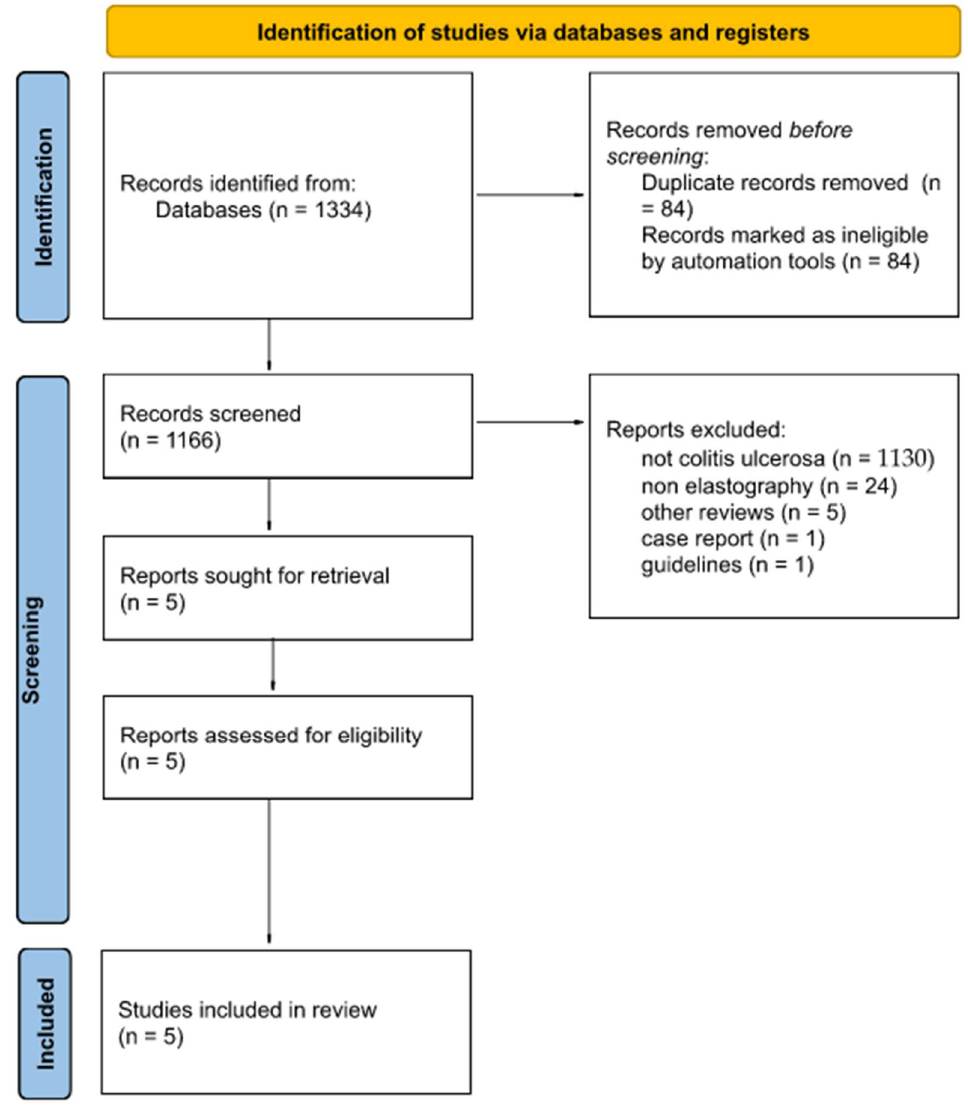
Figure 1. Flow diagram showing the course of the narrative review, taking into account the number of articles at a given stage of work.